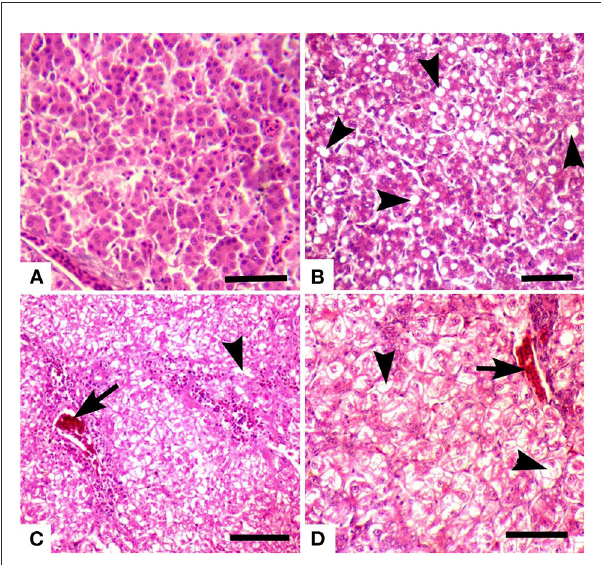
FIGURE6 Photomicrograph of the liver of broiler chicks stained with H&E (scale bar = 50): (A) control group showing no microscopic lesions, and hepatocytes have well-preserved lobular pattern, (B) group 6 (chromium + arsenic treated) showing advanced fatty change in hepatocytes (arrow heads), (C) group 2 (chromium treated) showing vacuolar degeneration (arrowheads) and congestion (arrow), and (D) group 3 (arsenic treated) showing vacuolar degeneration (arrowheads) and congestion (arrow).